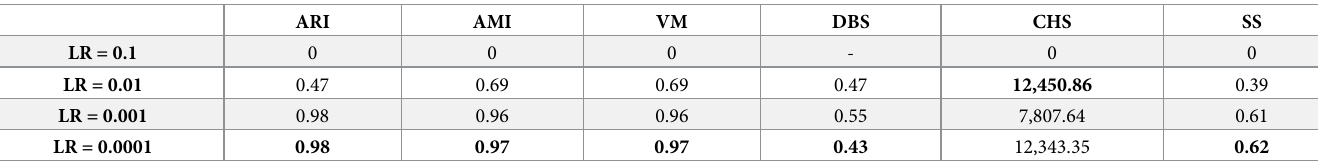
Table 4. Impact of learning rate comparison of different learning rates (LR) on the results of the AE variant on Sim4. The metrics show that a lower learning rate offers higher performance across the evaluation metrics with one exception, the CHS that is close to the highest value obtained, the values indicating the highest perfor- mance for each metric have been bolded.